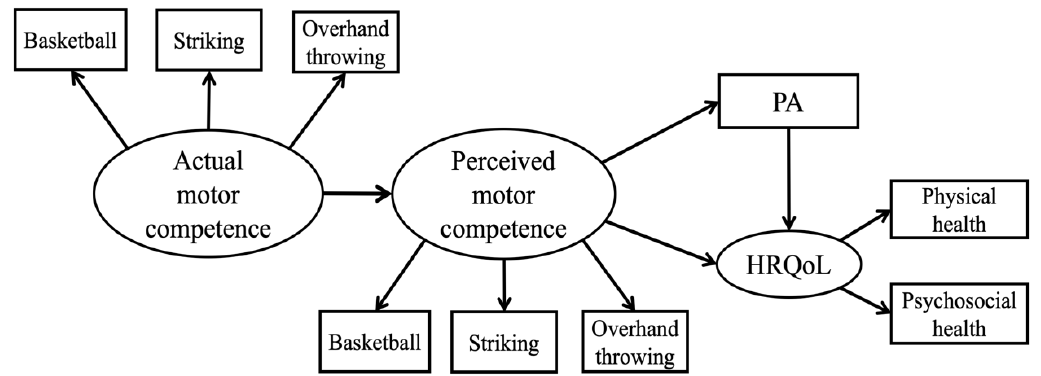
Figure 1. Hypothesized model of this study. PA = physical activity, HRQoL = health-related quality of life.